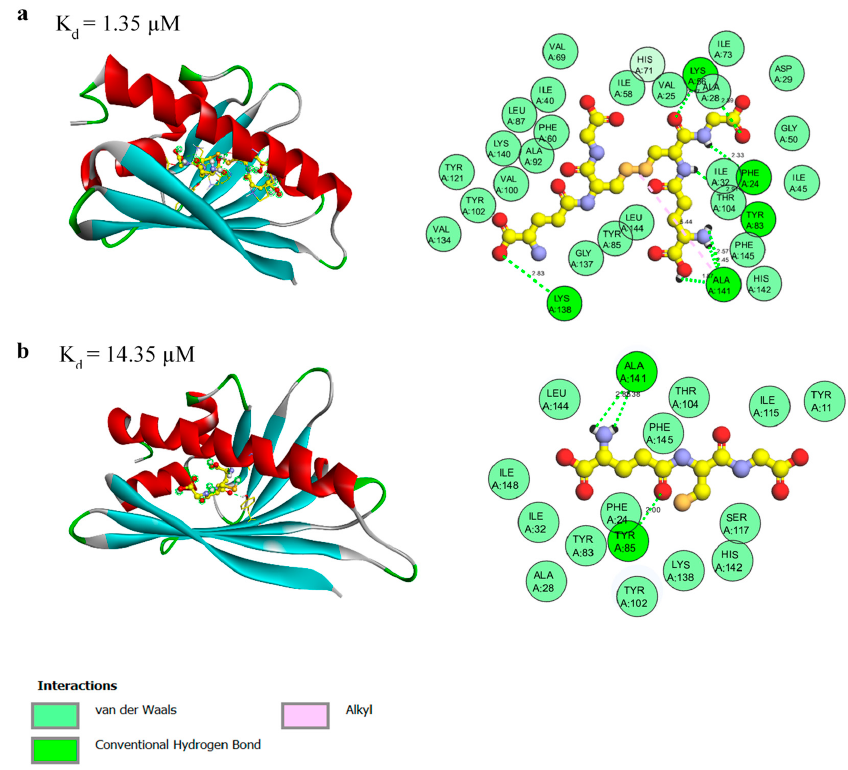
Figure 3. 3D ( left ) and 2D ( right ) interaction model of rMal d 1 in complex with GSSG ( a ) and GSH ( b ).